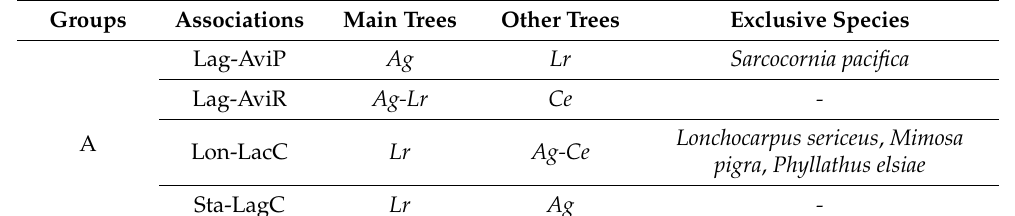
Table 2. Phytosociological groups/subgroups defined for Neotropical mangrove formations [47]. Aa , Acrostichum aureun ; Ag , Avicennia germinans ; Ce , Conocarpus erectus ; Lr , Laguncularia racemosa ; Pr , Pelliciera rhizophorae ; Rm , Rhizophora mangle